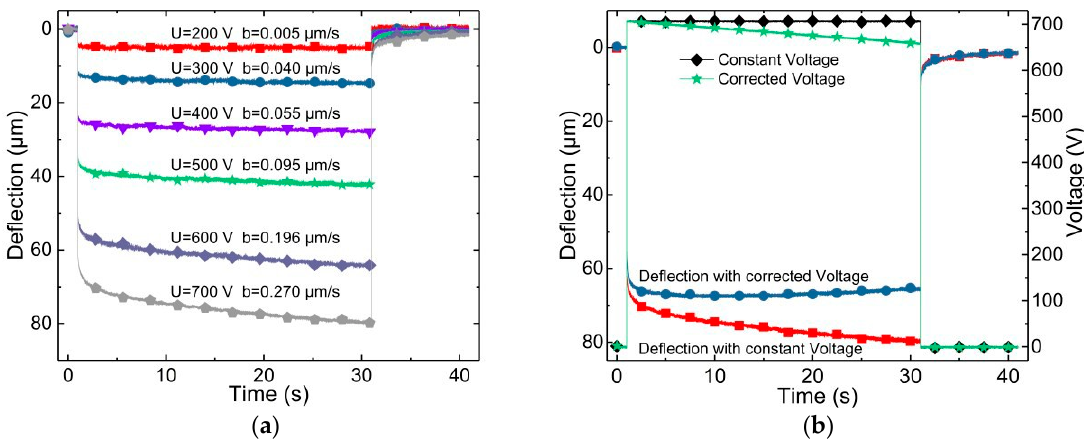
Figure 2. ( a ) Recorded membrane deflection behavior with various constant voltages applied. The linear creep rate b for the shown cases is listed above each dataset. ( b ) The creep compensation with an applied voltage of 700 V ( b ). The applied constant (black) and corrected voltage (yellow) are also